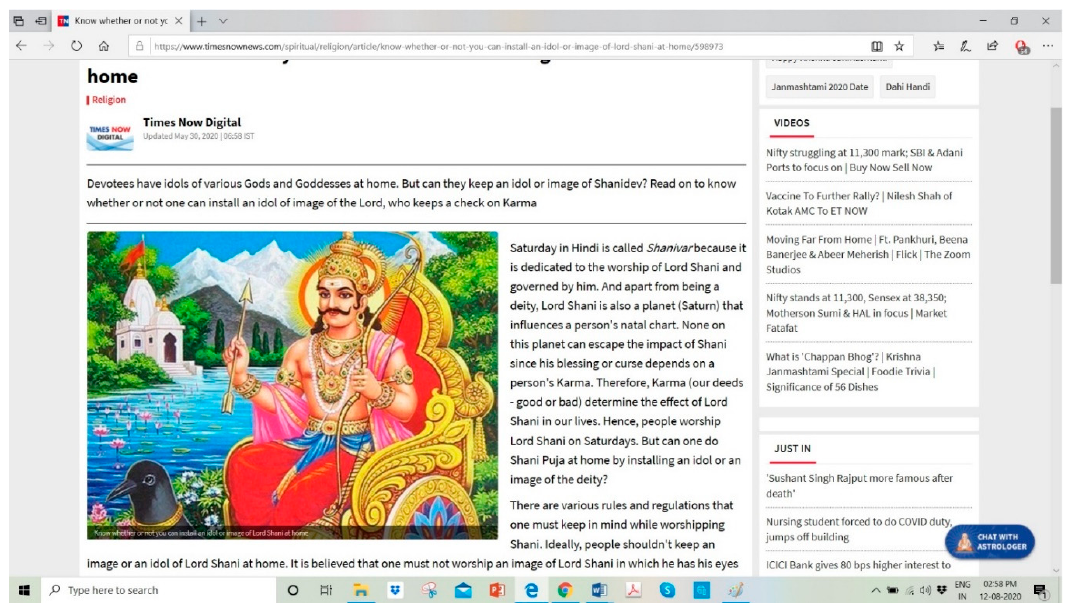
Figure 6. Shani with a pastoral background. Source: Times Now Digital.